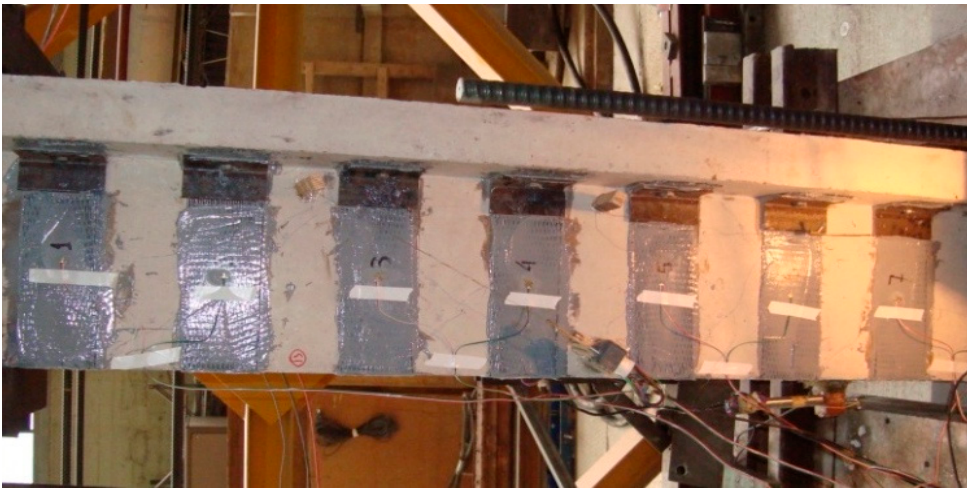
Figure 4. Specimen TB200L1t.